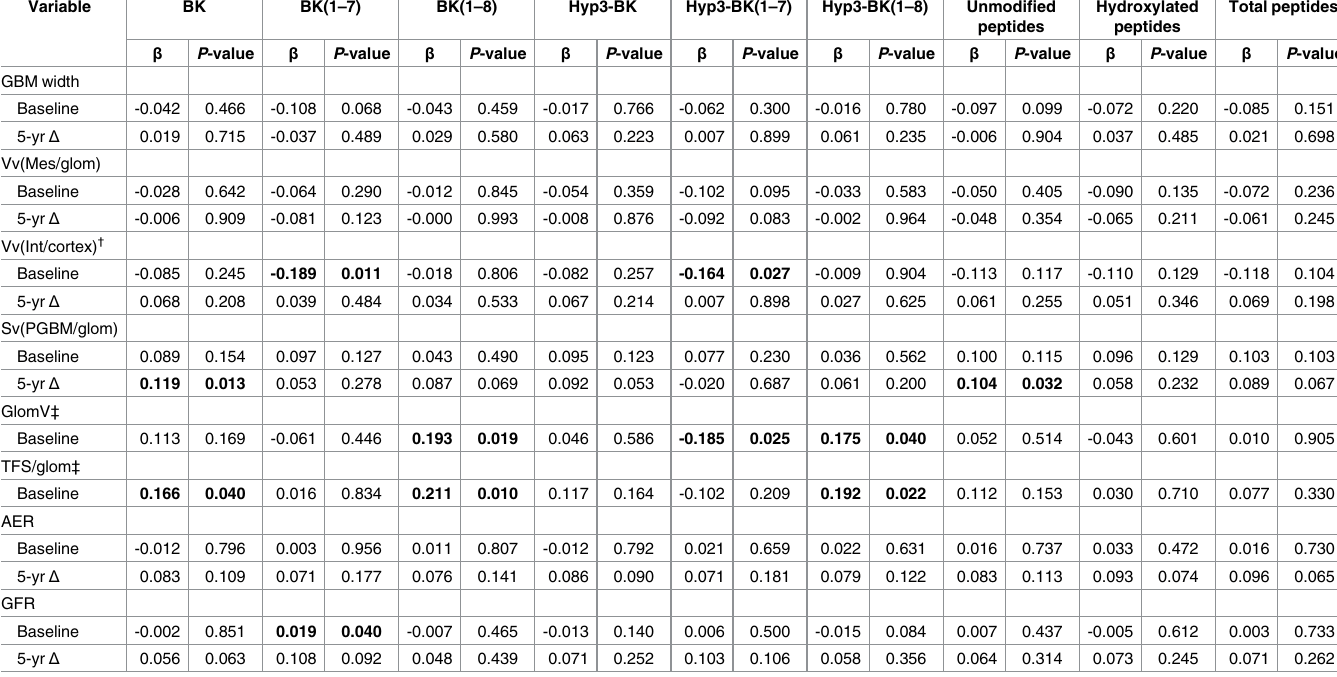
Table 3. Parameterestimatesfrom multivariate regression models * for the association between baseline plasma bradykinin and related peptides and the standardized baseline and log(5-year)-log baseline ( Δ ) morphometric variables in RASS. Variable